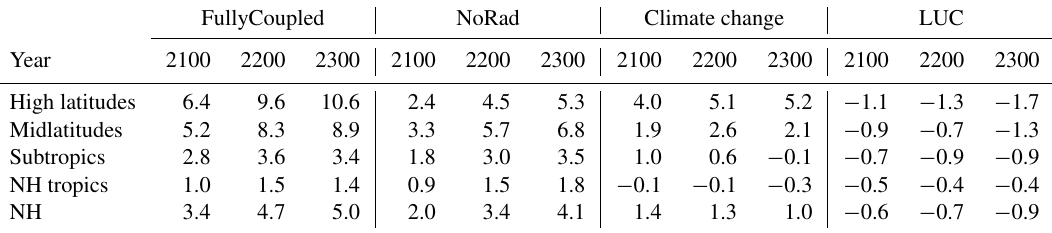
Table 3. Cumulative changes in mean CO 2 annual cycle amplitudes (ppm) from the 1950–1959 baseline in the FullyCoupled simulation, and the contributions of nonradiative forcing (CO 2 fertilization and N deposition), climate change, and LUC to the FullyCoupled amplitude changes averaged over the NH high latitudes, midlatitudes, subtropics, tropics, and the NH.